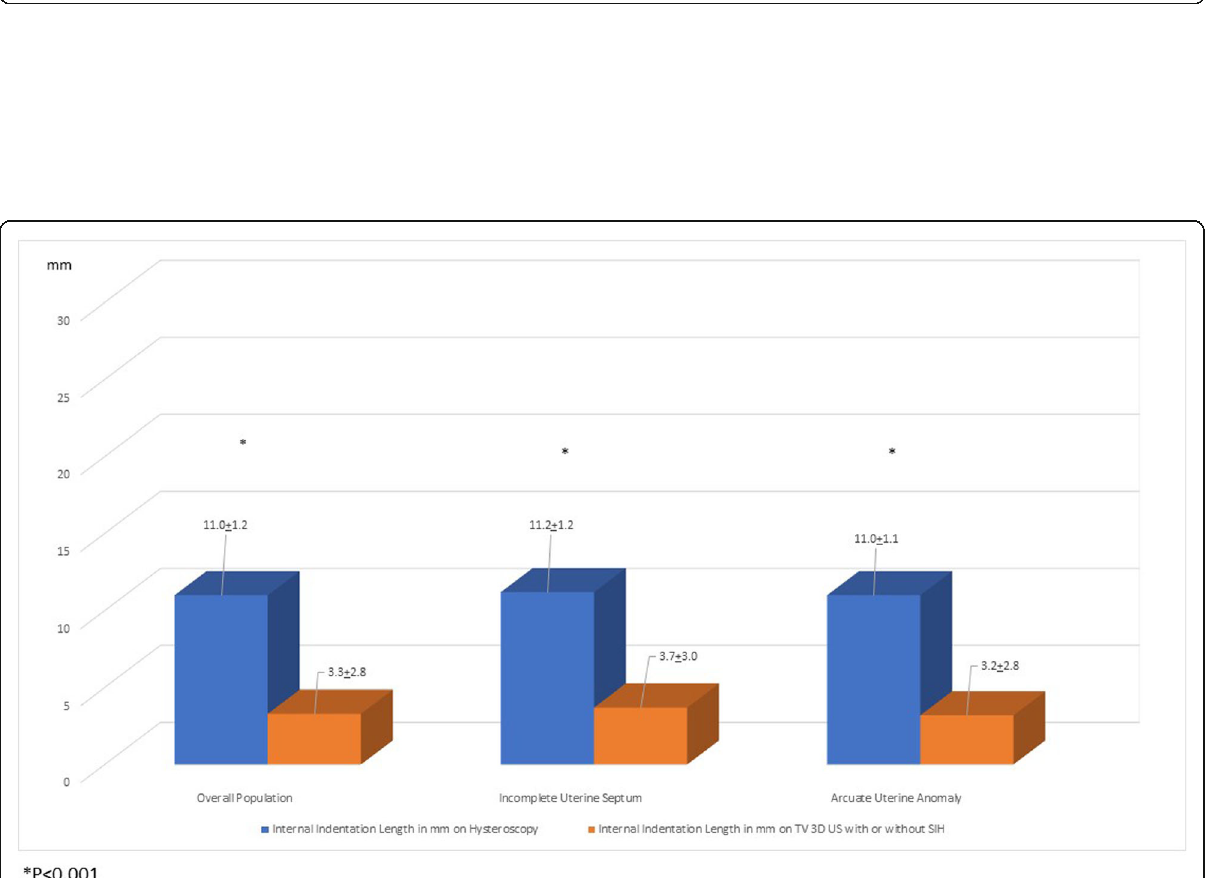
Fig. 4 Comparison between the mean IILFM measured in millimeter on hysteroscopy and on TV 3D US with or without SIH, in patients with IUS, significant AUA, and in the overall population in all patients